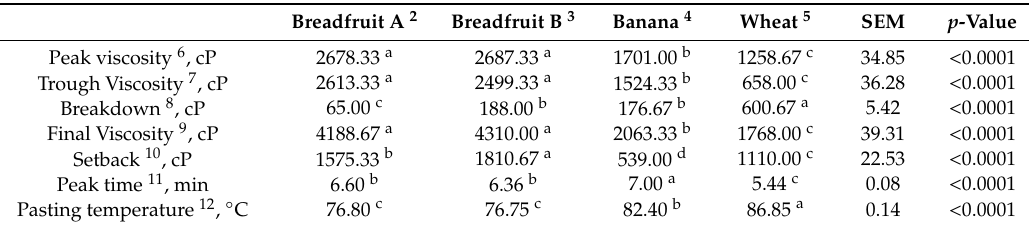
Table 4. The pasting properties of tropical flours compared with a traditional flour using RVA method #1 (maximum temperature of 95 ◦ C) 1